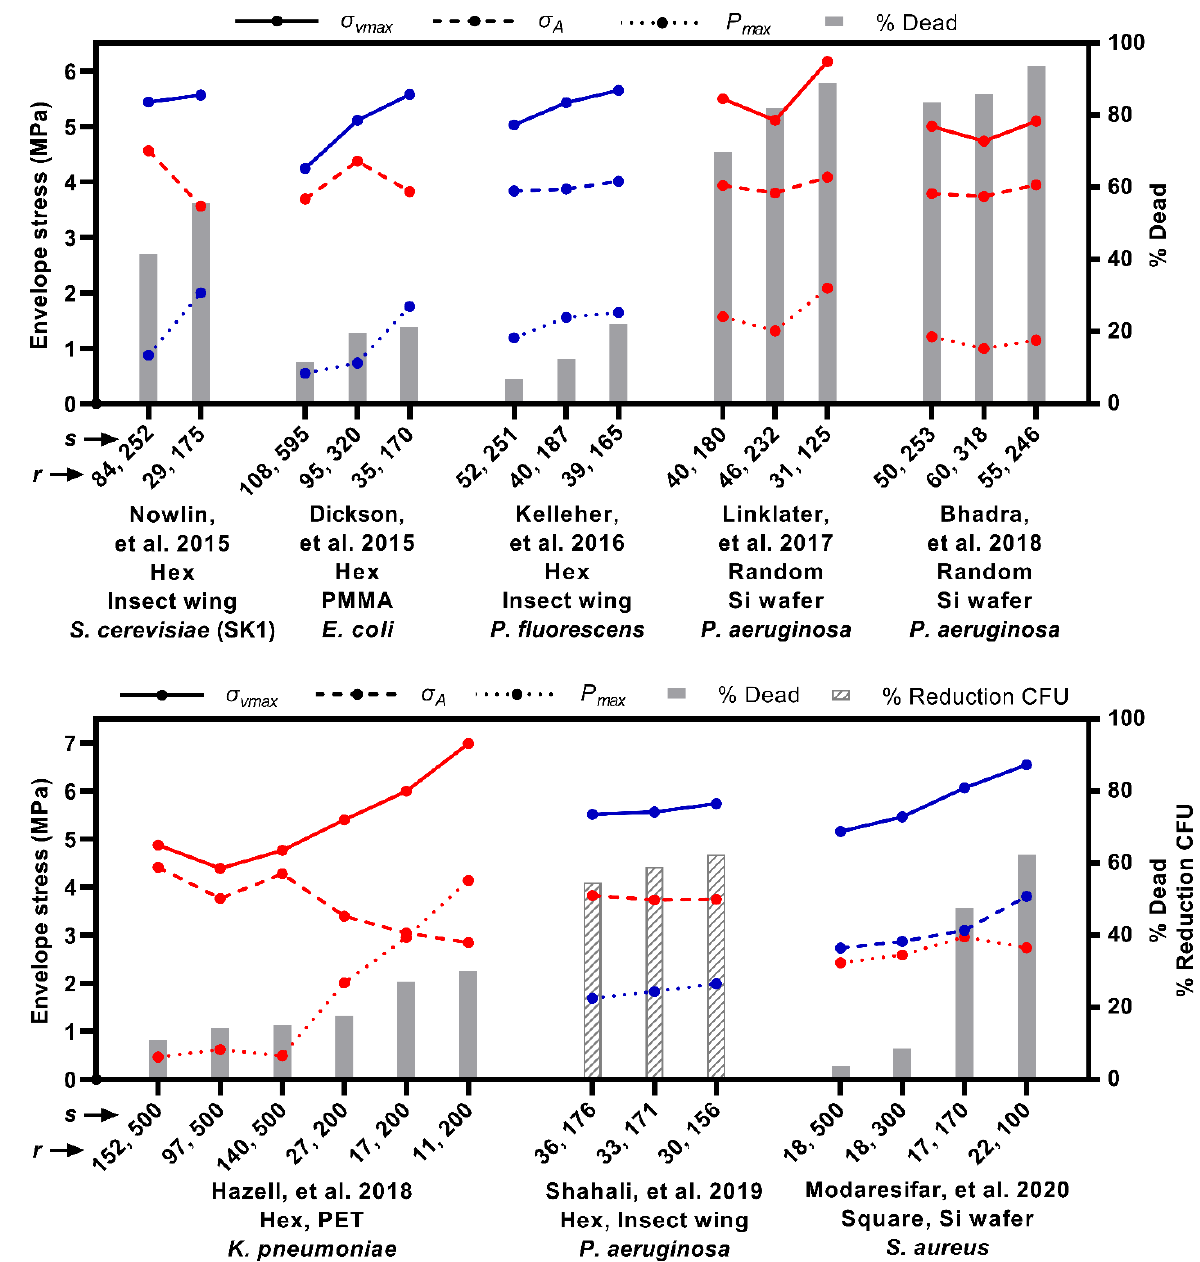
Figure 6. Comparison with previous experimental results to illustrate correlation between stress metrics and killing efficiency. Text in x -axis label cites the referenced study, and includes a description of the nanopattern ordering, material, and tested species in the study. Numbers in x -axis label pertain to the tip radius, r , and center spacing, s , of the nanopatterns investigated in the study. Right y -axis and bars plot the reported killing efficiency in terms of % dead or % reduction CFU, arranged in increasing order. Left y -axis and connected points plot the calculated areal stress (dashed line, σ A ), maximum contact pressure (dotted line, P max ) and maximum von Mises stress (solid line, σ vmax ) for each of the nanopatterns (i.e., the indicated r and s values were entered into the model). A blue colored line highlights when the trends in the calculated stress and the reported killing efficiency agreed qualitatively (i.e., both consistently increased). A red colored line indicates disagreement. All calculated trends were demonstrated for the case K A = 200 mN/m, κ = 25 × 10 − 20 J and w = 20 mJ/m 2 .